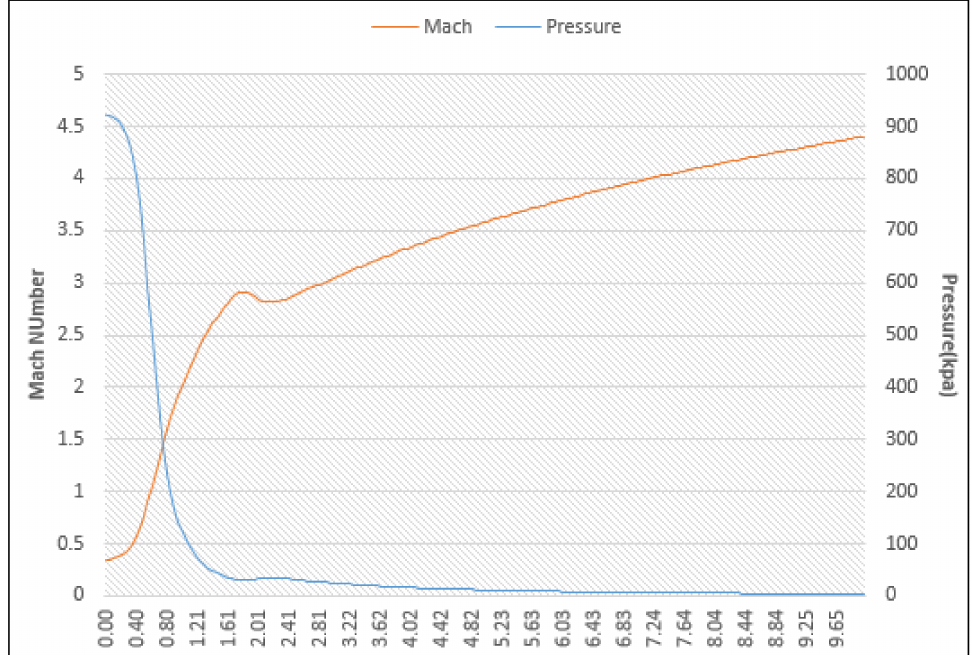
Figure 17. Mach and pressure plots against nozzle